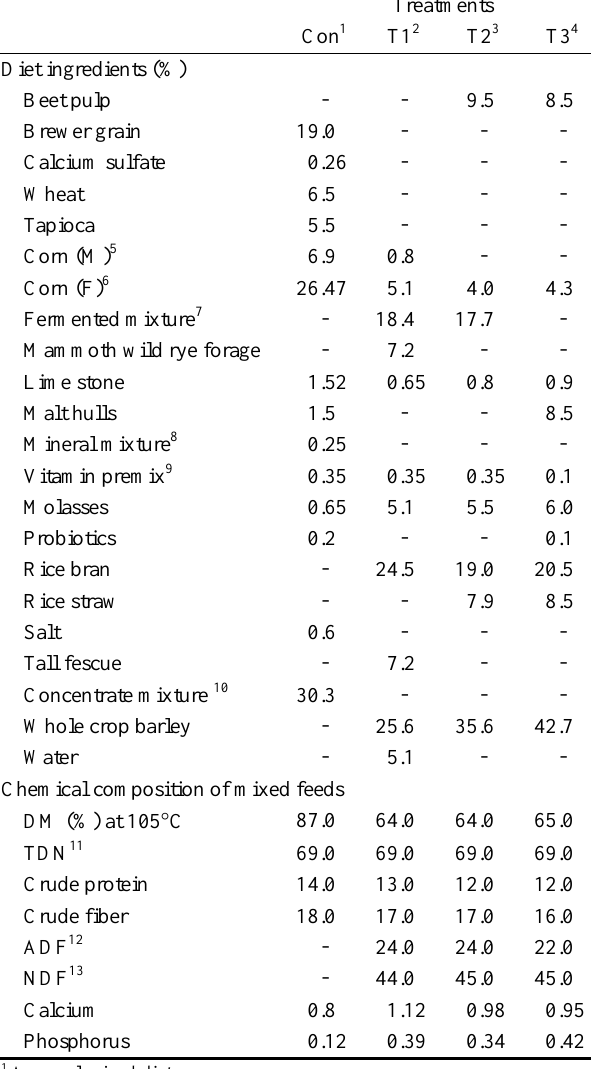
Table 1. Ingredient and chemical composition of the experimental diets for Exp.